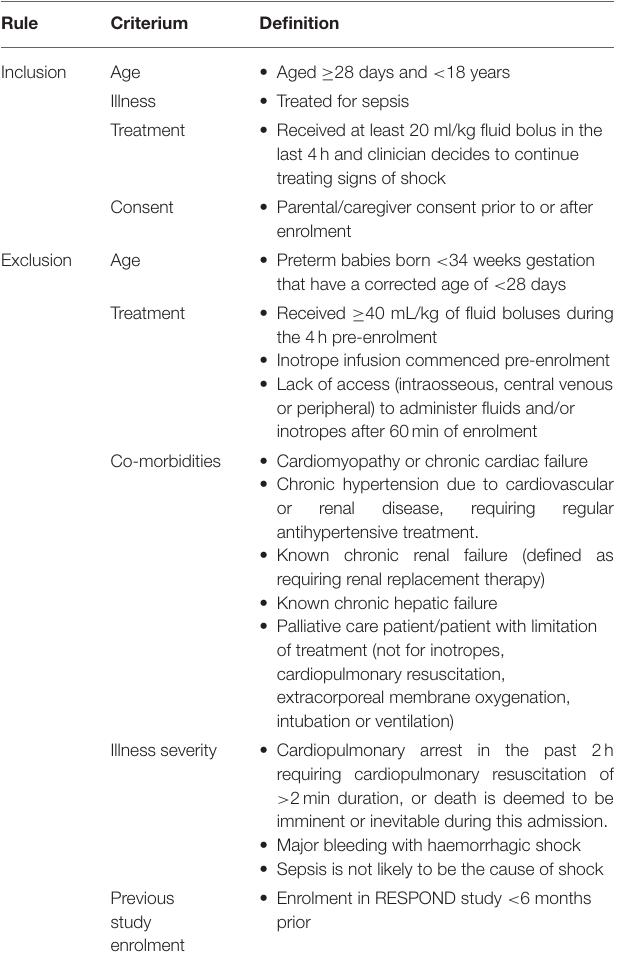
TABLE 1 | Inclusion and exclusion criteria. Rule